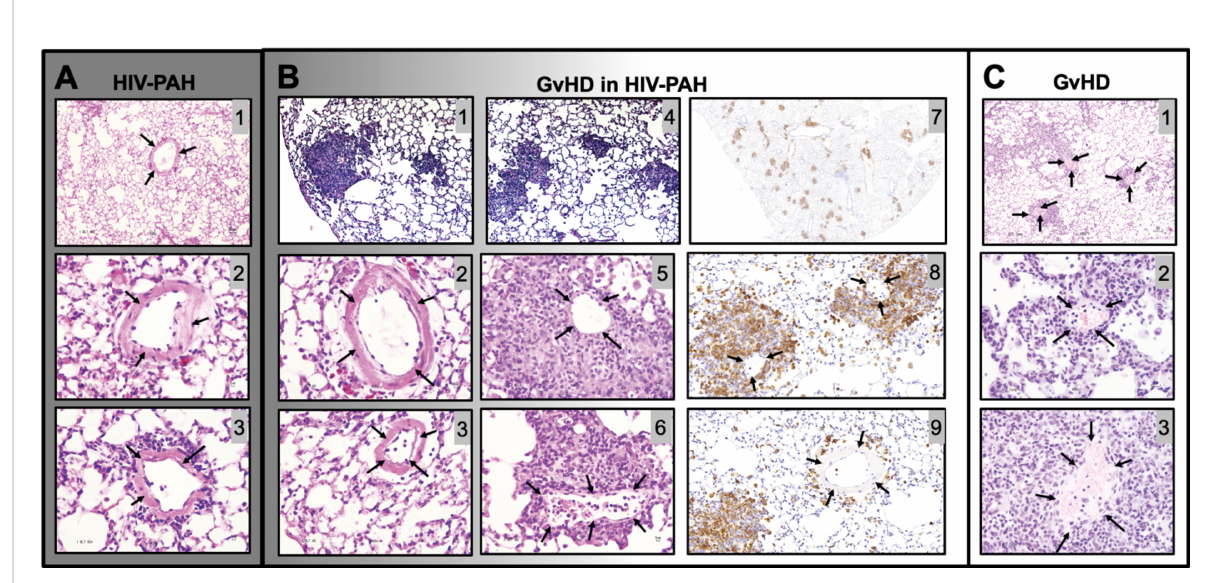
FIGURE 8 Histopathological comparison between graft vs host disease (GvHD) and HIV-PAH. (A) Representative images of formalin- fi xed paraf fi n- embedded lung tissue showing diffused in fl ammation and muscularized pulmonary vessels in humanized mice with HIV-PH. Mice were exposed to hypoxia and HIV infection. (B) Histological characteristics in an HIV-infected humanized mouse that developed GvHD. The mouse presented with a combination of substantial patchy in fl ammation (photomicrographs 1,4) and diffuse in fl ammation with evident pulmonary vascular muscularization. Muscularized vessels were outside of the in fl ammatory patches (photomicrographs 2-3), while signi fi cant vascular thinning was observed within the dense in fl ammatory areas, as shown in photos 5-6. Photomicrographs 7-9 show CD3 immunohistochemistry in the HIV- infected humanized mouse with Pulmonary Hypertension and GvHD. Tissue sections were treated with anti-CD3 antibody, counterstained with hematoxylin (blue), and visualized with DAB (brown). CD3 staining in pulmonary vessels within (Photo 8) and outside (Photo 9) granuloma is shown. (C) Classical pulmonary vasculature in a mouse model of allogeneic GvHD presenting muscular thinning within in fl ammatory patches. Arrows point to pulmonary